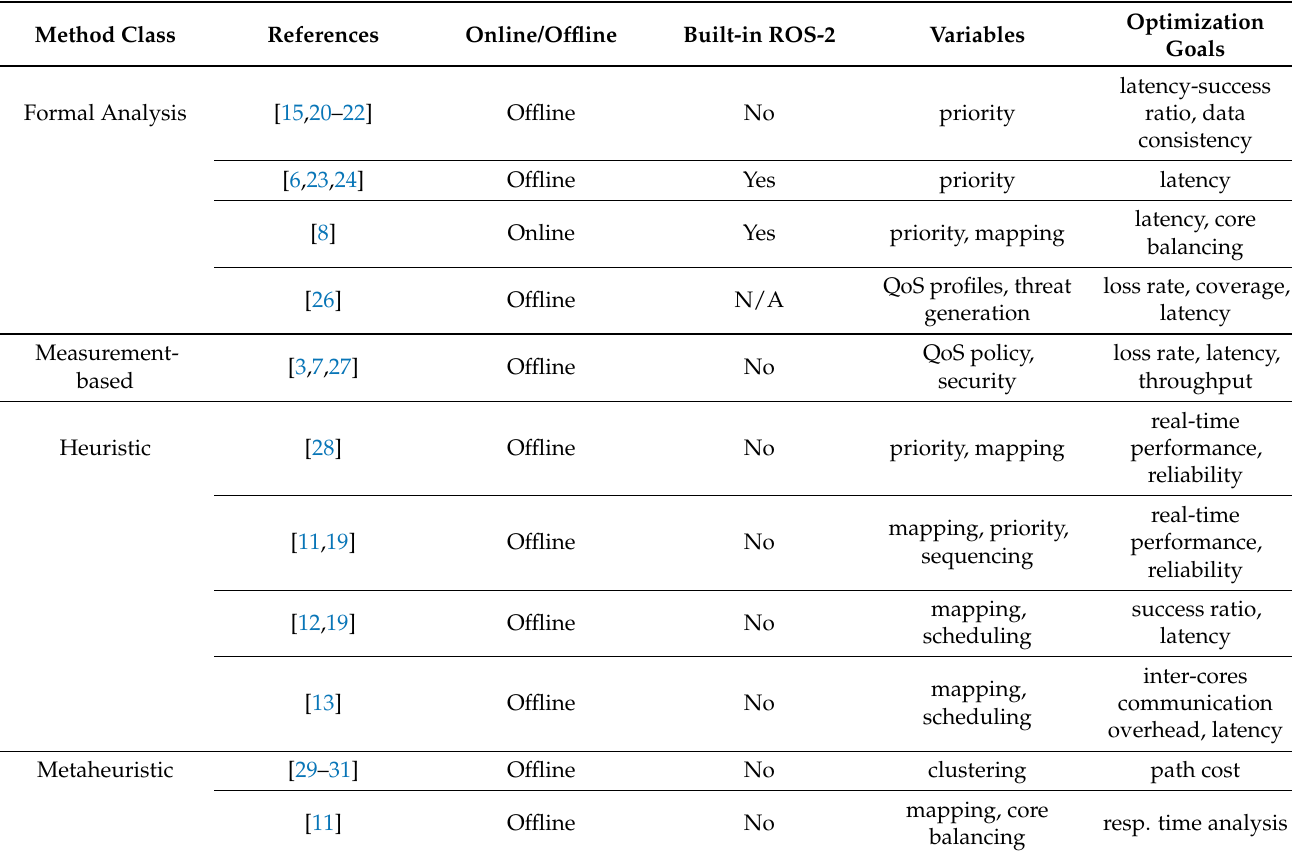
Table 1. Summary of related